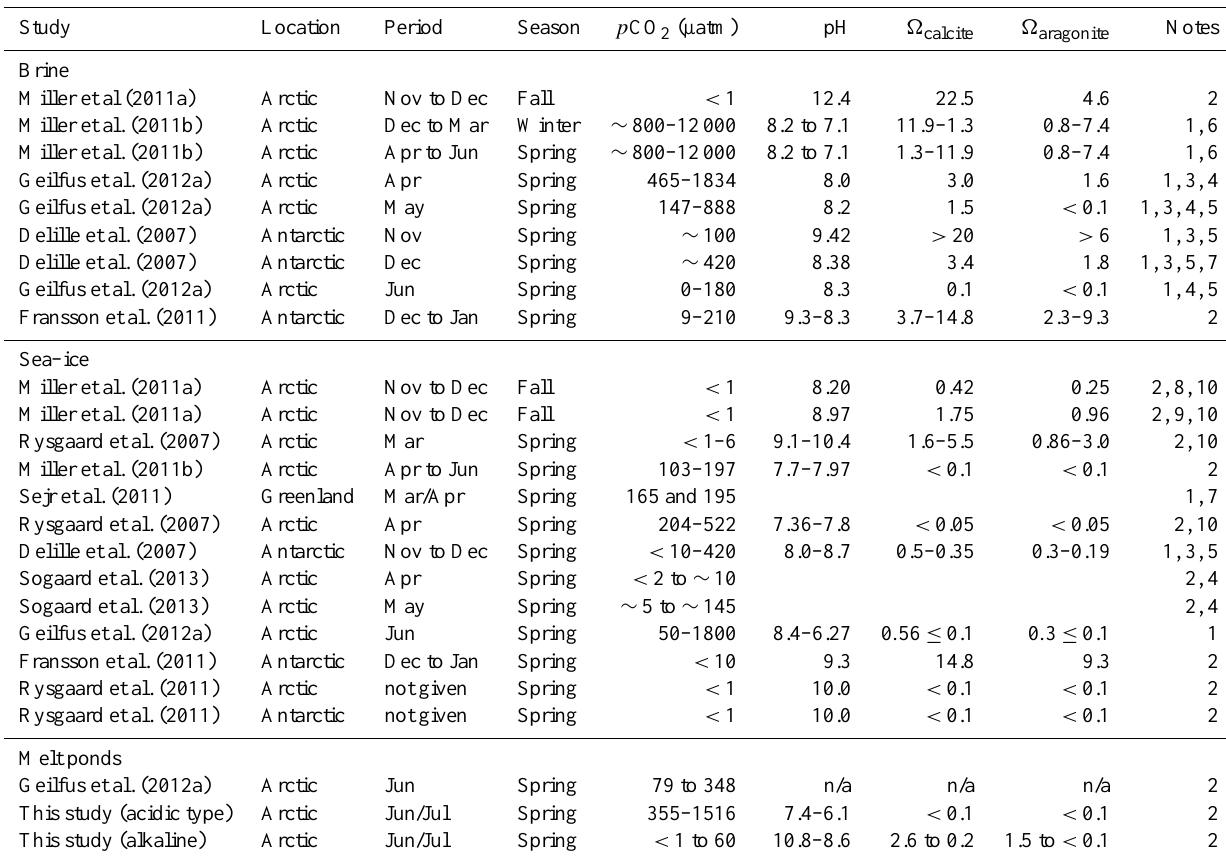
Table 1. Summary of measured and calculated p CO 2 values reported in sea-ice brine, sea-ice and melt ponds. The studies are arranged in seasonal order from fall to spring observations where possible. In most cases, p CO 2 , pH, (cid:127) calcite , and (cid:127) aragonite were calculated from TA and DIC, or from p CO 2 and pH. In the cases where values were reported in the original study, salinity and temperature values of 4 and 0 ◦ C were used in the calculations. Where possible, ranges are given or calculation of mean observations reported in the original literature. Please note that the ranges of pH are in reverse order to p CO 2 to reflect the end-member ranges of high p CO 2 /low pH and low p CO 2 /high